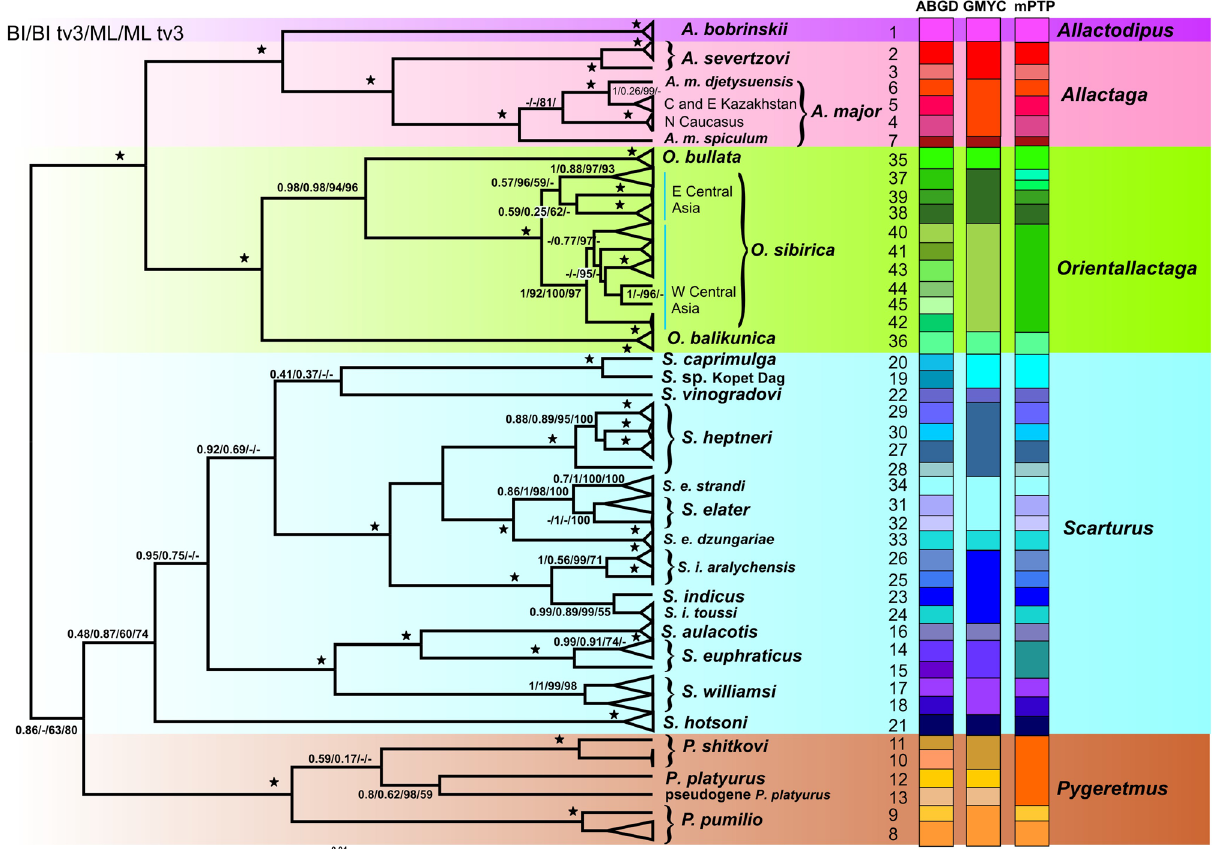
Figure 3. The phylogeny of Allactaginae produced by the BEAST algorithm based on the cytb gene sequences and the results of the ABGD, GMYC, and mPTP species delimitation analysis. Values above the branches correspond to posterior probabilities in BEAST and bootstrap support (1000 pseudoreplicates) in the ML analyses of all codon positions in cytb and 1st + 2nd + transversions of 3rd position, respectively (BPP/BPPtv3/